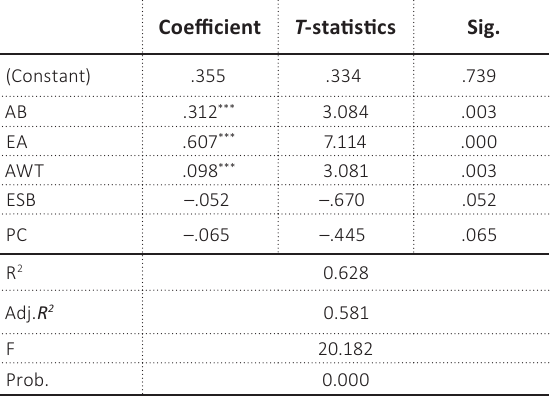
Table 4. OLS regression